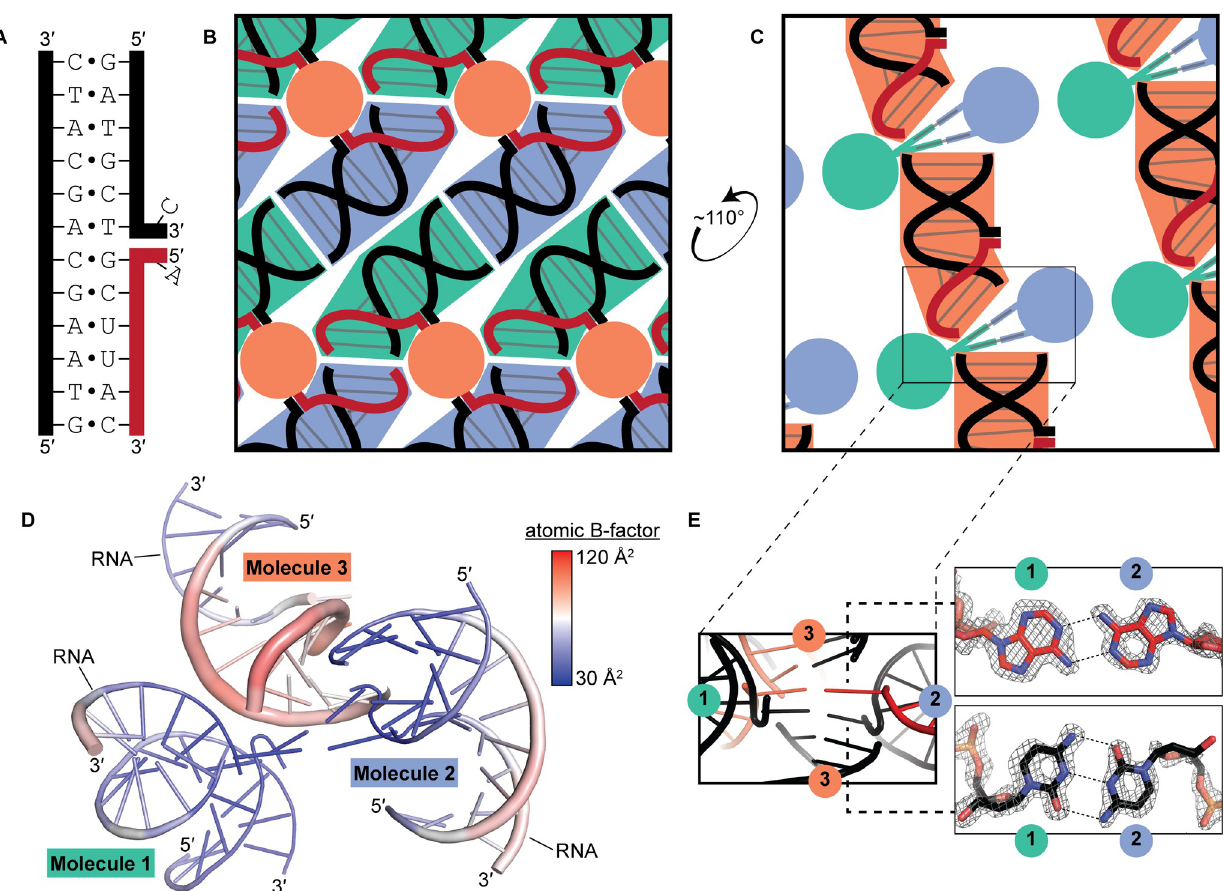
Fig 1. Stabilizing features of the crystal lattice. (A) Crystallization construct sequence. Black, DNA; red, RNA. (B) Schematized drawing (not to scale) of the crystal lattice along a direction that depicts the helical network formed by Molecules 1 and 2. Green shading, Molecule 1; blue shading, Molecule 2; orange shading, Molecule 3 (cross section). (C) Similar to panel B, but along a direction that depicts the helical network formed by Molecule 3. (D) Asymmetric unit colored by atomic B-factor. The thickness of the cartoon model also reflects the local B-factors. (E) Model and 2mF o -DF c map (sharpened by -38 Å 2 , displayed at 3.3 σ ) of the Ade-Ade and Cyt-Cyt base pairs (contributed by the flap nucleotides of Molecules 1 and 2) that bridge the helical network formed by Molecule 3. Distortion in the map is due to diffraction anisotropy (see